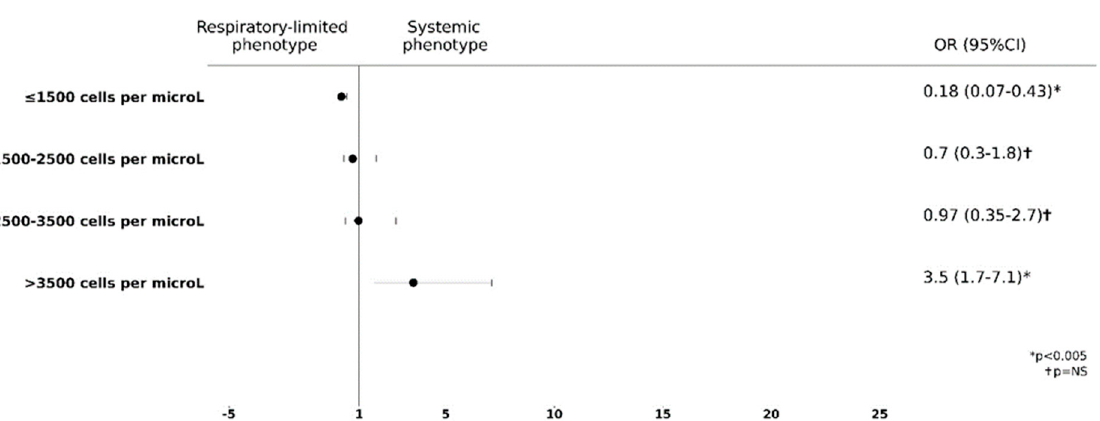
Figure 2. Prediction of extra-lung involvement using blood eosinophil count as a predictor (Logistic Regression).